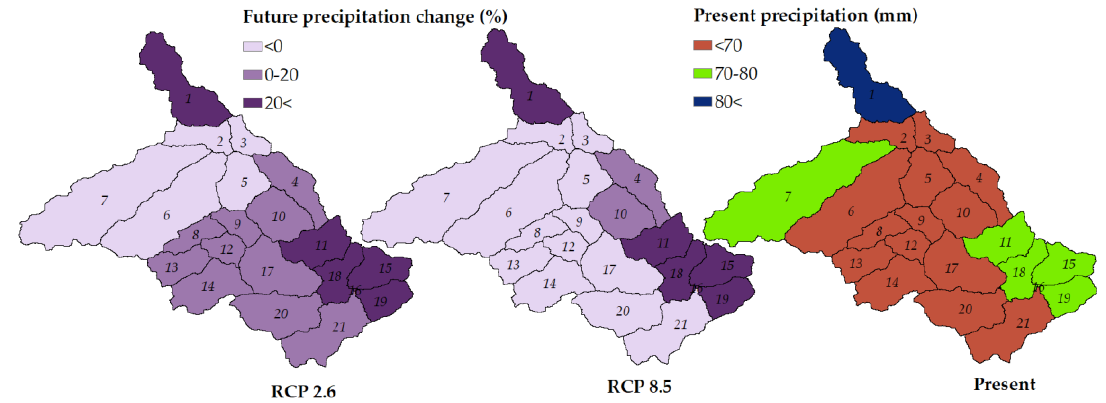
Figure 5. Spatial precipitation pattern at present and precipitation change in percent in the near future (RCP 2.6 and RCP 8.5).